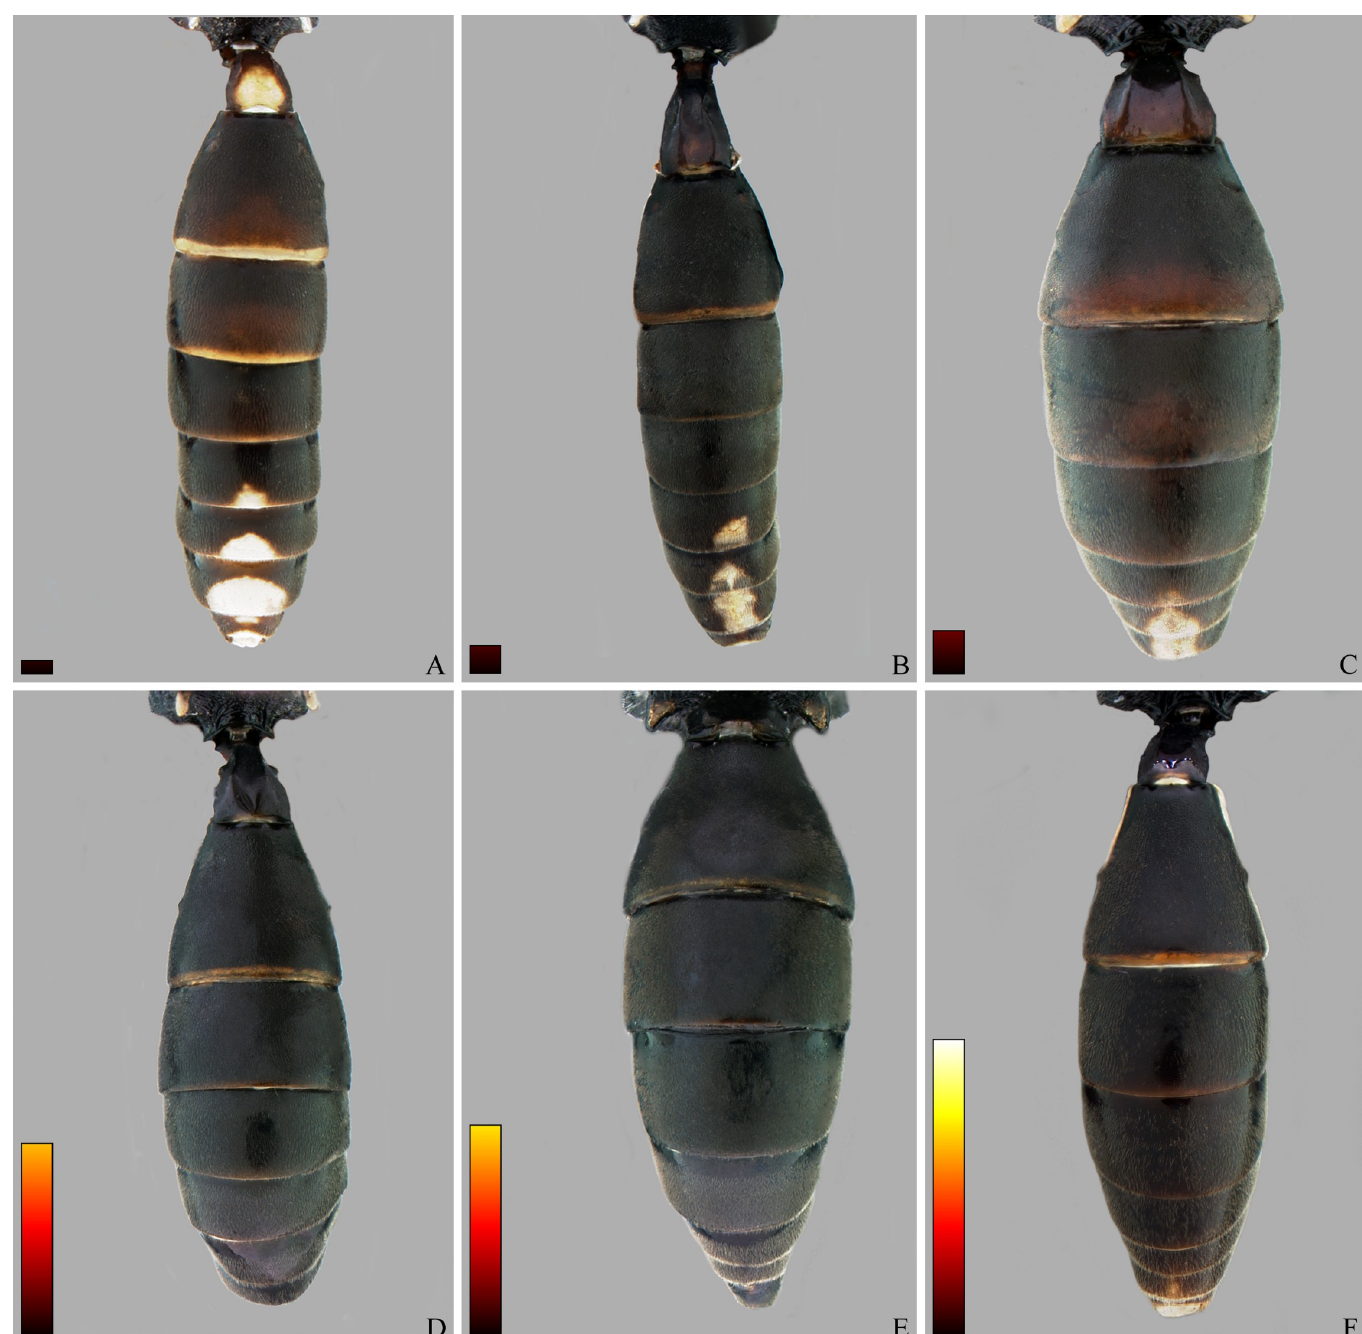
Fig 16. Cryptoxenodon metamorphus sp. nov. from the paratype series. Female metasoma, dorsal view. (A) FAS4606, Alt. 36m, Brazil/PA. (B) FAS4605, Alt. 75m, Colombia. (C) UFES45548, Alt. 115m, Brazil/BA. (D) FAS1165, Alt. 513m, Brazil/ES. (E) FAS331, Alt. 561m, Brazil/ES. (F) UFES41706, Alt. 790m, Brazil/ES. Bars are proportional to the